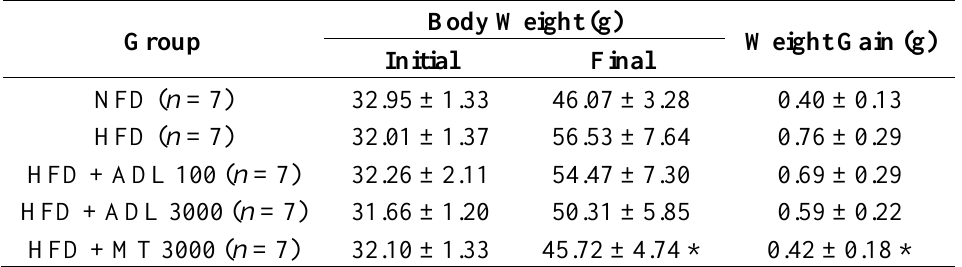
Table 2. Effects of Allomirina dichotoma larva (ADL) on body weight